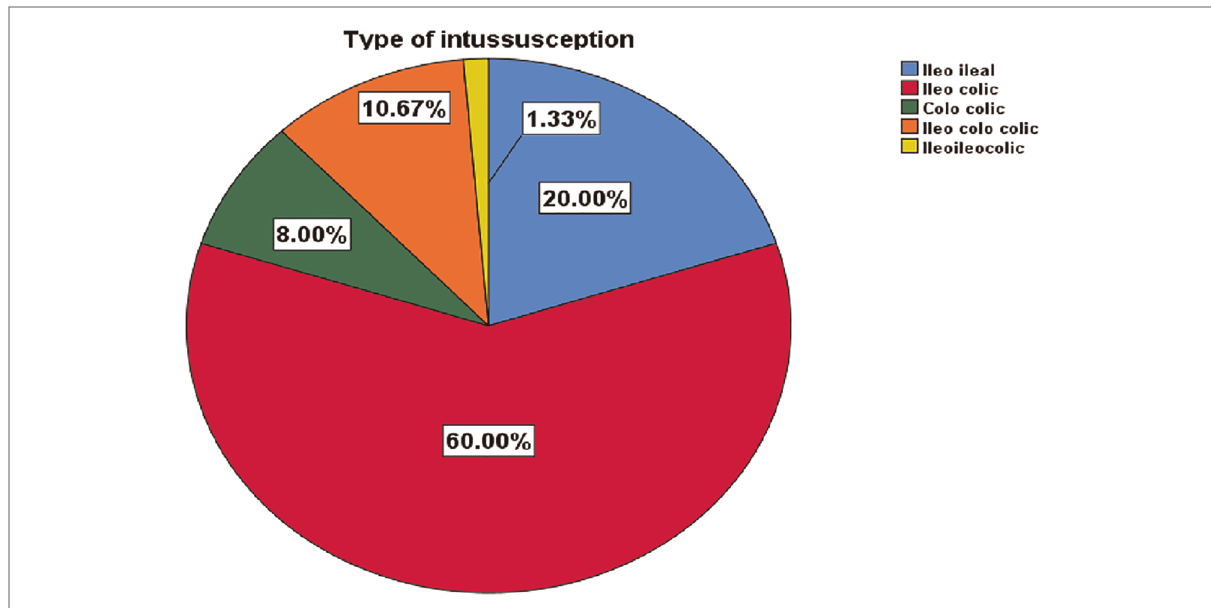
FIGURE 2 Type of acute intussusception among children admitted and managed for acute intussusception at HFSUH, Eastern Ethiopia, 2021 ( n =75).